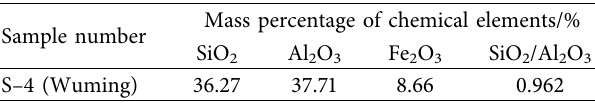
Table 4: Analytical results by chemistry element analysis tests.